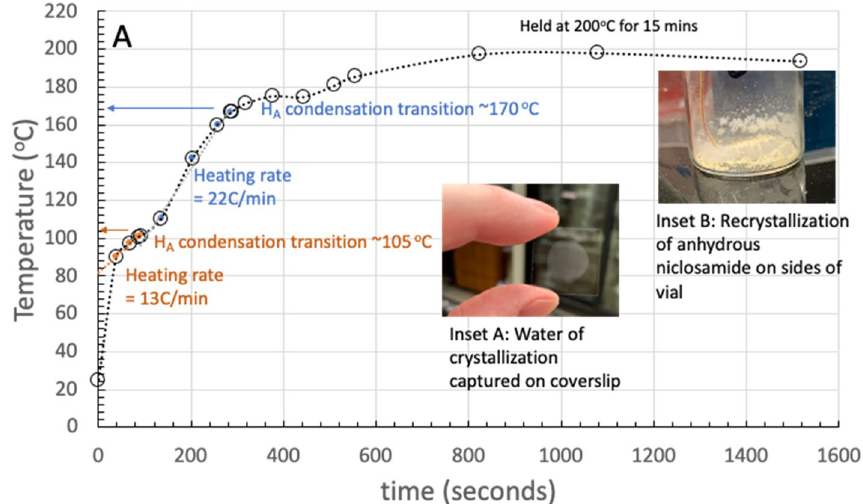
Fig. 7 Experimental set up for heating 100 mg of Yomesan powder warmed in a 20 mL scintillation vial equipped with a thermocouple, placed in the powder, and heated slowly on a heating plate. Heating rates and H A (orange) and H B (blue) transitions each observed by condensation on a cover glass (Inset A). Held at 200 °C, niclosamide appeared to recrystallize on the sides of the vial (Inset